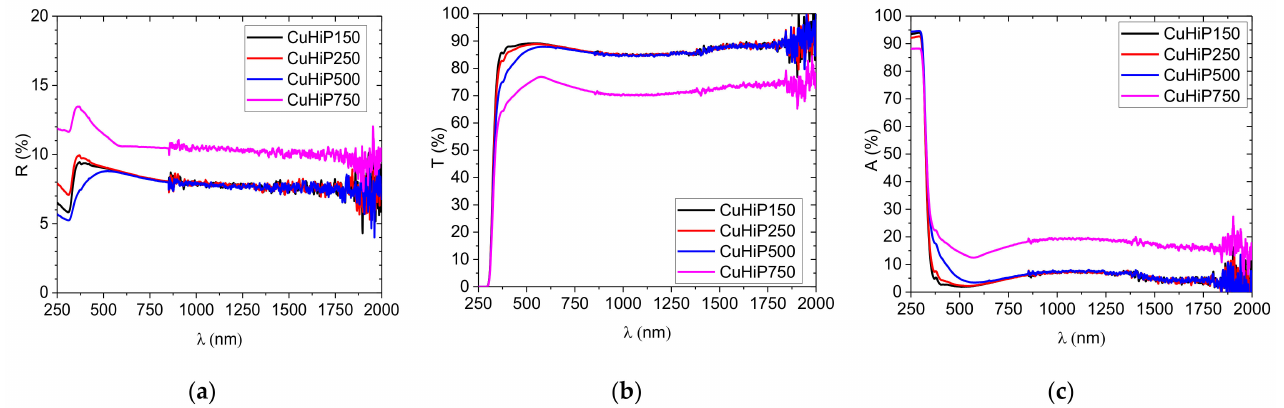
Figure 2. Spectrophotometric curves, ( a ) reflectivity, ( b ) transmittance and ( c ) absorbance of Cu thin films deposited at different average HiPIMS power and a peak current of ~60